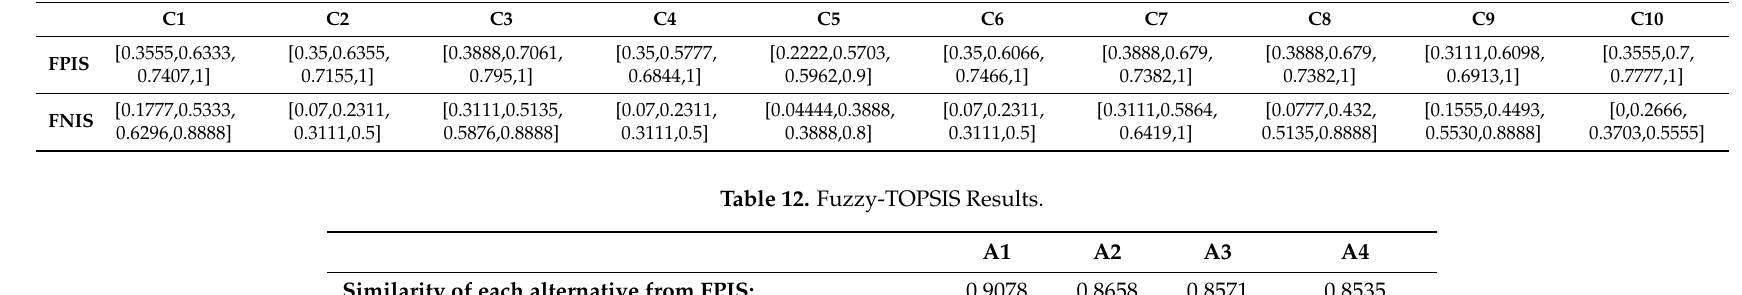
Table 11. Fuzzy positive and negative ideal solutions (FPIS & FNIS).